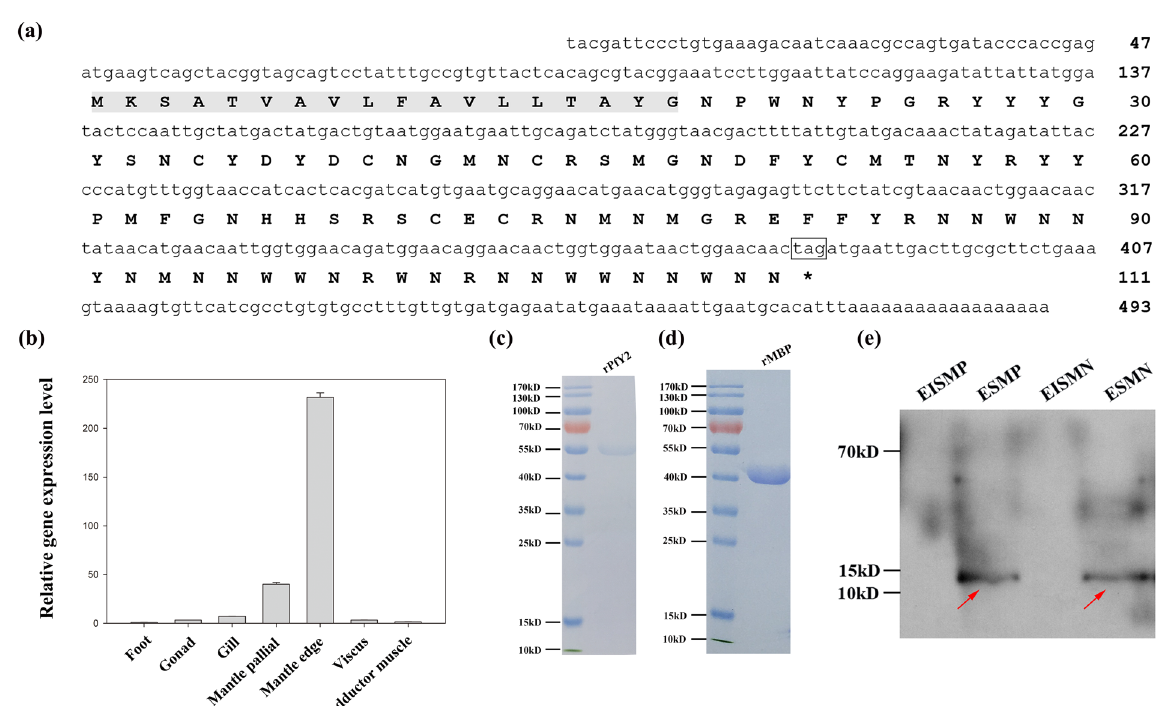
Figure 1. Identification of PfY2 as a matrix protein. ( a ) The cDNA sequence information of PfY2. The shaded section is the signal peptide. Black box is the transcription termination site. ( b ) Expressional analyses of PfY2 in various tissues by RT-PCR. Values for RT-PCR are means ± standard deviation of three replicates. ( c ) SDS- PAGE of recombinant protein PfY2 with MBP tag at 55 kD. ( d ) SDS-PAGE of recombinant protein MBP tag at 40 kD. ( e ) Detection of native PfY2 in the shell via Western Blotting. The red arrow indicated the band of the native PfY2 in shell components. EISMP, EDTA-insoluble fraction from prismatic layer; ESMP, EDTA-soluble fraction from prismatic layer; EISMN, EDTA-insoluble fraction from nacreous layer; ESMN, EDTA-soluble fraction from nacreous layer. Please refer to Suppl. Fig. S4 to get the primary gel